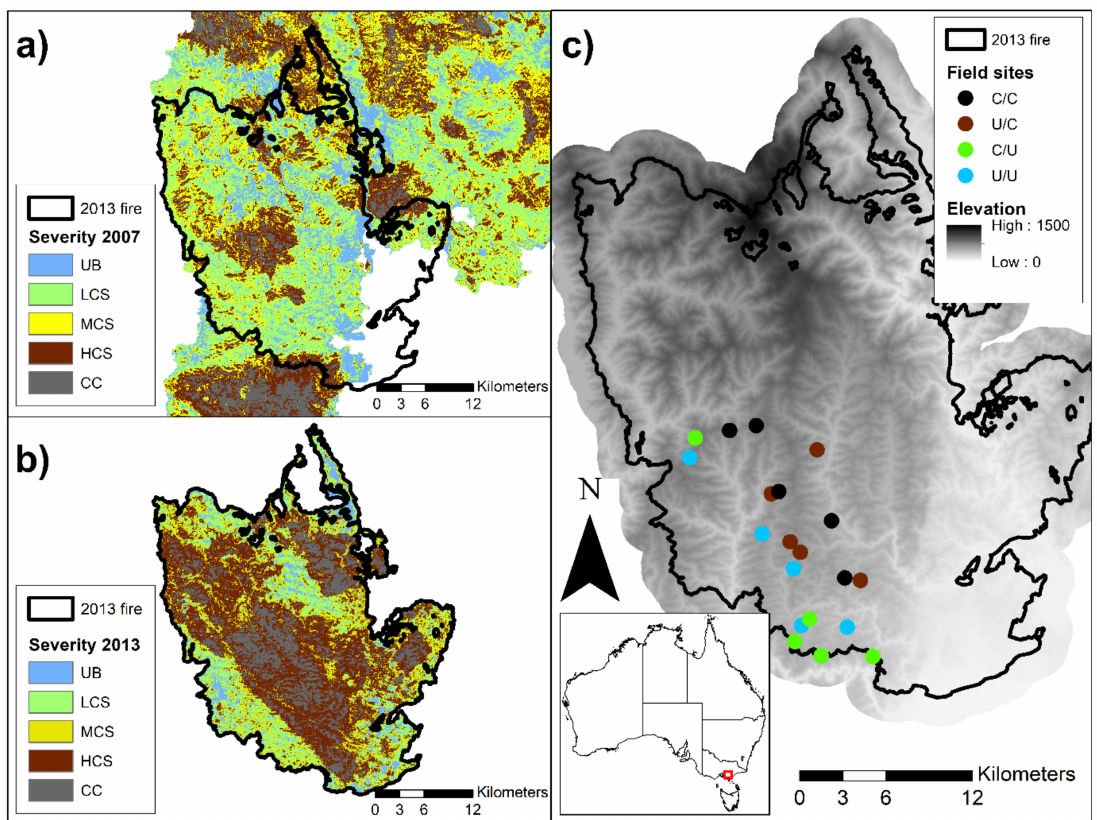
Figure 1. Severity maps for the ( a ) 2007 Great Divide wildfire and ( b ) 2013 Aberfeldy wildfire. Panel ( c ) shows the location of the study area (red square in the inset) and the field sites used to assess the effect of the fire combinations on fuel properties. The footprint of the 2013 Aberfeldy wildfire has been included in each panel to provide a reference. The fire severity classes presented in panels ( a , b ) are unburnt (UB), low canopy scorch (LCS), moderate canopy scorch (MCS), high canopy scorch (HCS) and canopy consumption (CC). Descriptions of these severity classes are provided in Section 2.2. The fire severity combinations presented in panel ( c ), which describe the severity of the 2007 and 2013 fires, are understorey fire followed by an understorey fire (U/U), canopy fire then an understorey fire (C/U), understorey fire then a canopy fire (U/C) and canopy fire then a canopy fire (C/C). Descriptions of these severity combinations are provided in Section